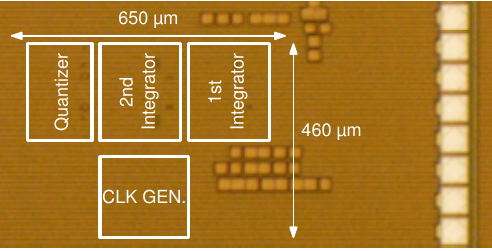
Figure 7. Schematic diagram of the modulator.